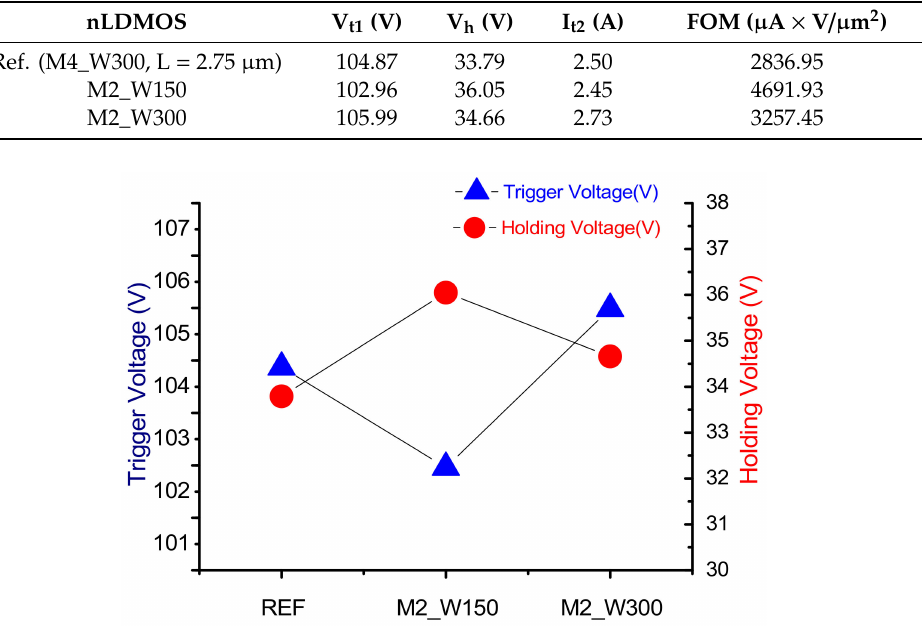
Figure 13. Trigger voltage / holding voltage distribution charts of HV nLDMOSs with channel- width